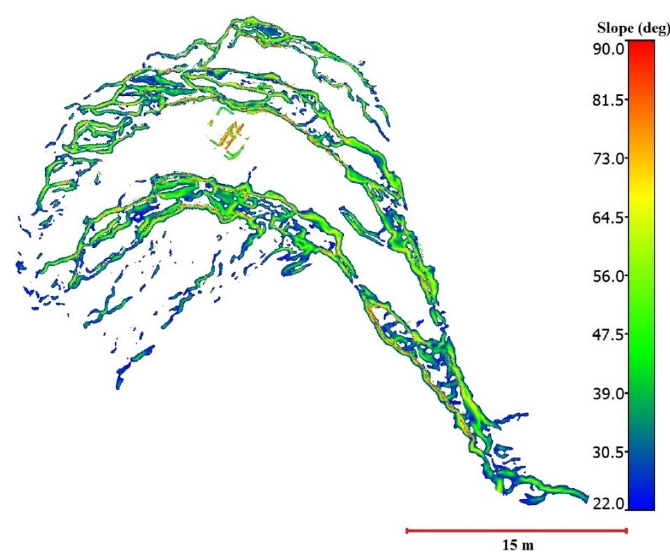
Figure 20. Distribution of the identified Salhoub/Al-Juaidieh landslide scarp features based on local slope variations.